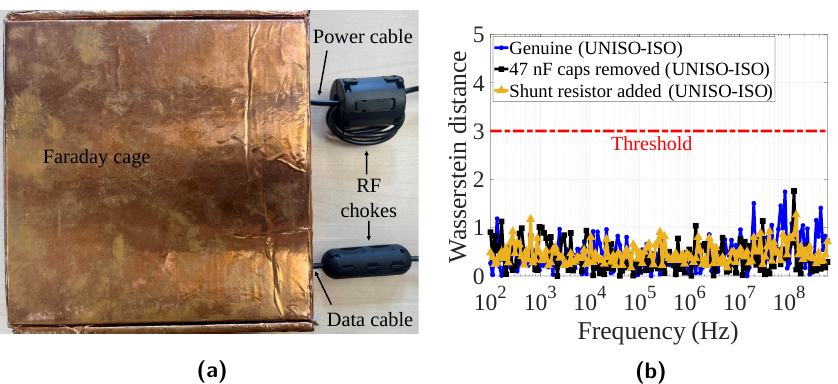
Figure 15: (a) The Faraday cage setup used for isolated measurements. (b) Wasserstein distance between isolated (ISO) and unisolated (UNISO) measurements for the genuine board, removing 47 nF capacitors, and adding shunt resistor